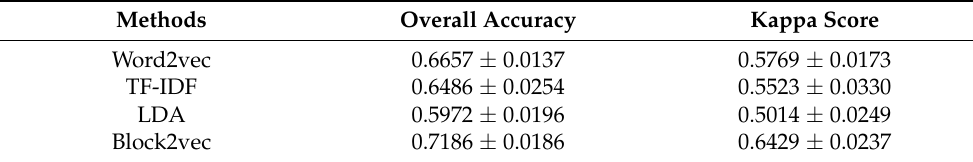
Table 2. Accurate assessment of urban functional region classification via different methods.